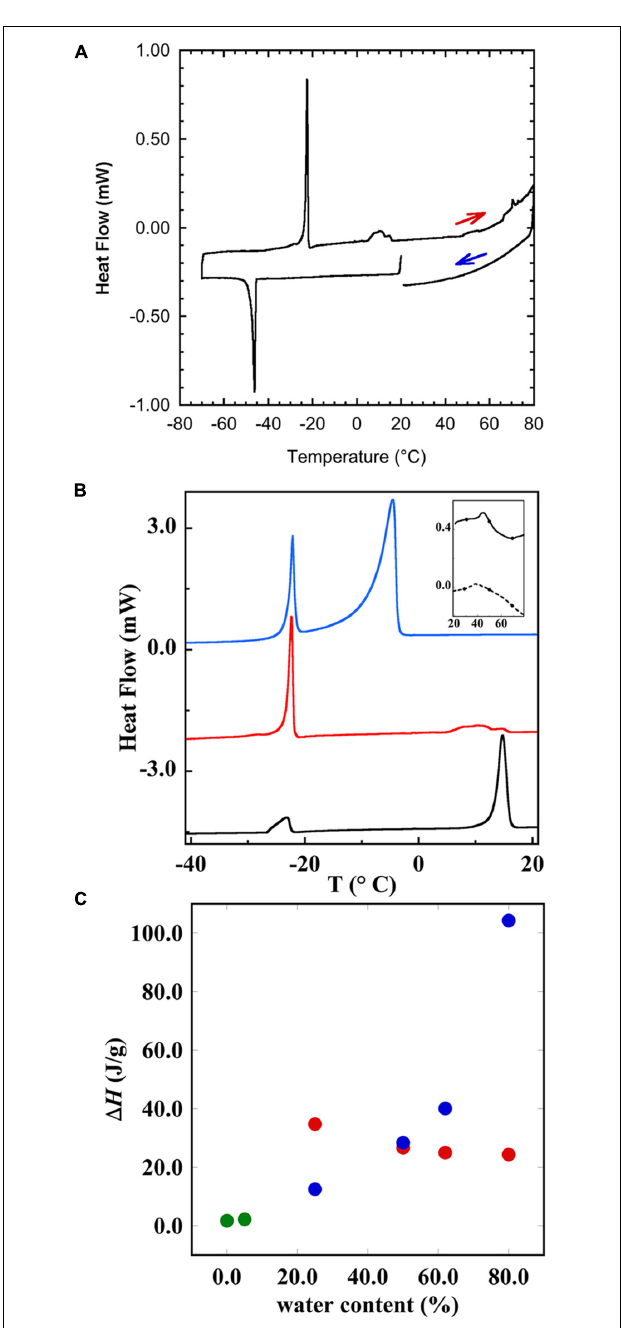
FIGURE 9 | Differential scanning calorimetry (DSC) showing the thermal response of brain lipid extract in 0.9 wt% NaCl and 1 mM CaCl 2 . (A) The thermogram of 50 wt% brain lipid extract in 0.9 wt% NaCl and 1 mM CaCl 2 , where the heating and cooling cycles are indicated. The vertical line indicates the start of the cooling—heating—cooling cycle. The samples were first cooled from 20 ◦ C to -60 ◦ C at 10 ◦ C/min, and then heated up to 80 ◦ C at 5 ◦ C/min and eventually cooled at the same rate down to 20 ◦ C. (B) The thermograms upon heating, where the different curves correspond to different aqueous content [salt solution with 0.9 wt% (154 mM) NaCl and 1 mM CaCl 2 ] of 25 wt% (black), 50 wt% (red), and 80 wt% (blue)]. The inset shows the thermograms obtained from the pure brain lipid extract (full line) and from its